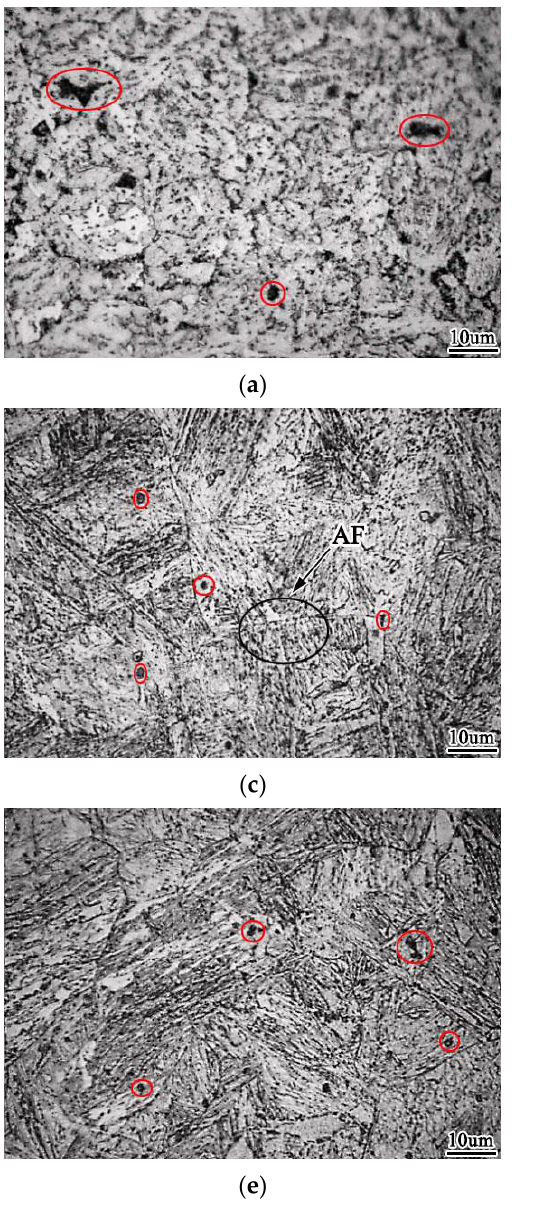
Figure 6. Effect of Zr contents on morphology of weld metal ( a ) 0% Zr ( b ) 0.0028% Zr ( c ) 0.0061% Zr ( d ) 0.0087% Zr ( e ) 0.0135% Zr.